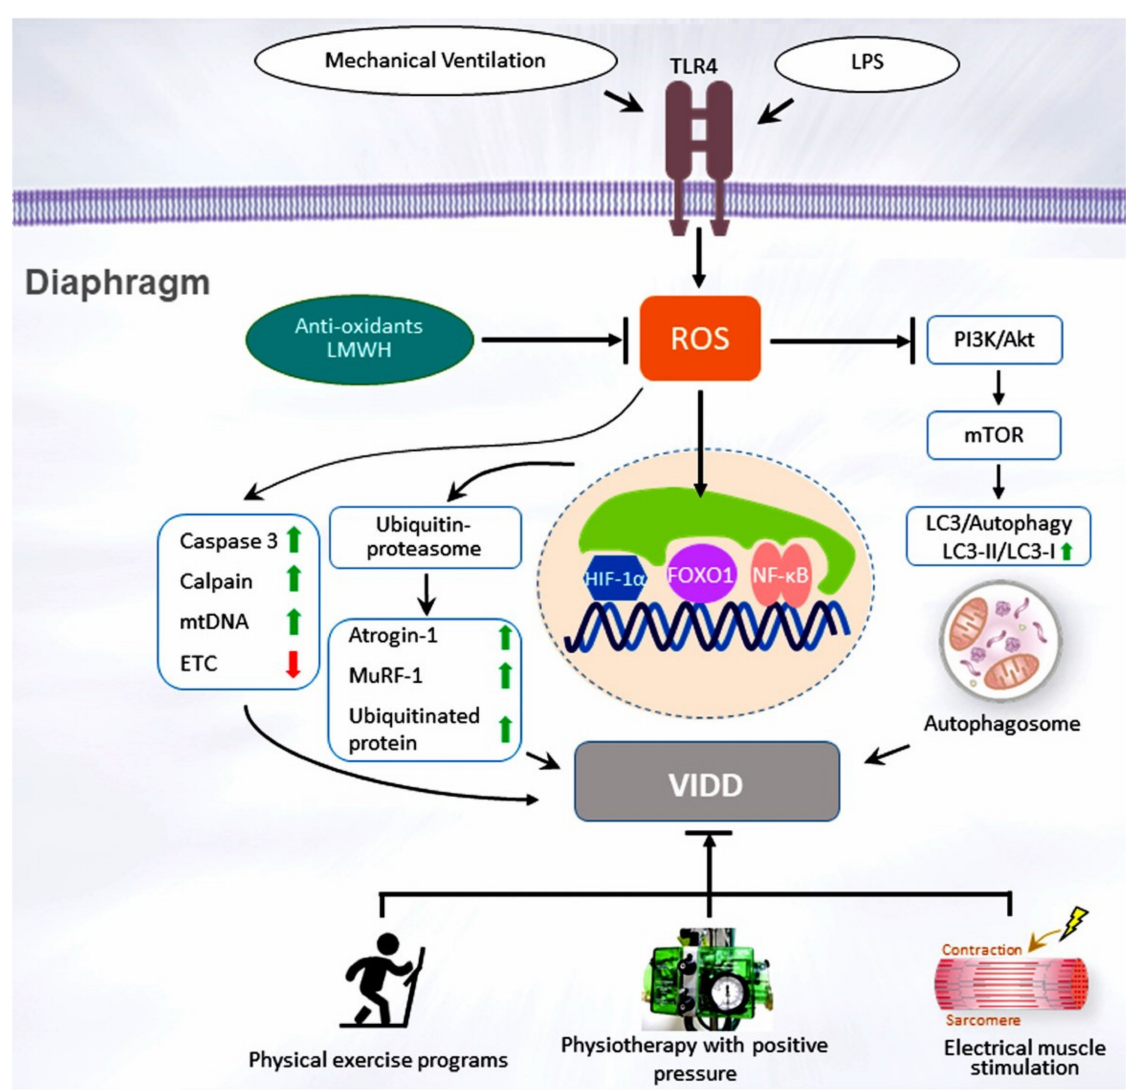
Figure 1. Schematic figure illustrating the signaling pathway implicated in VIDD development. Endotoxin-induced augmentation of mechanical stretch-mediated ROS generation and